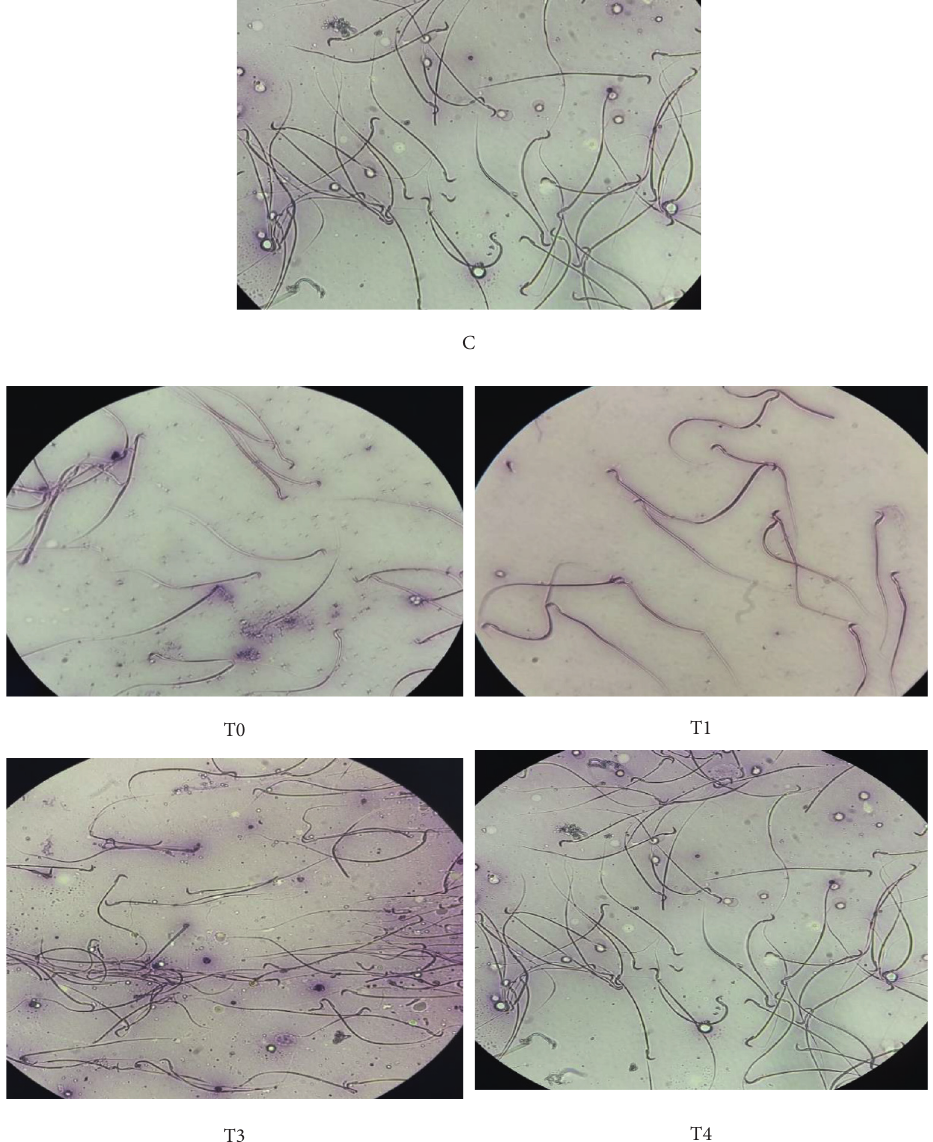
Figure 1: Live and dead sperm of rat exposed to TCDD and treated with α -tocopherol. Rats in the control group (C) were administered 0.5mL of corn oil twice daily at 4h intervals for 45d Rats in groups T0, T1, T2, and T3 were administered TCDD 700ng/kg BW daily and 4h later were administered corn oil, 77, 140, and 259mg/kg BW daily α -tocopherol, respectively, for 45d Live spermatozoa do not absorb color on the head, whereas dead spermatozoa absorb a red-purple color from the stain (eosin-nigrosin staining), at 400 × magnification under a light microscope Nikon E200 (Tokyo,